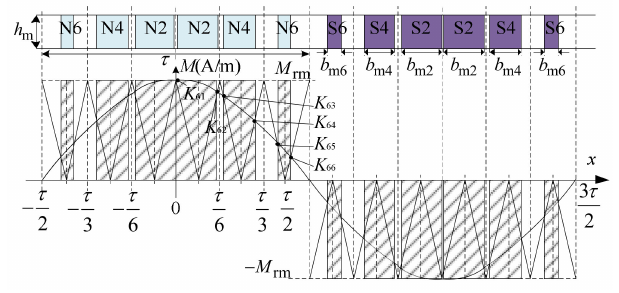
Figure 8. Structure of Array II with s =